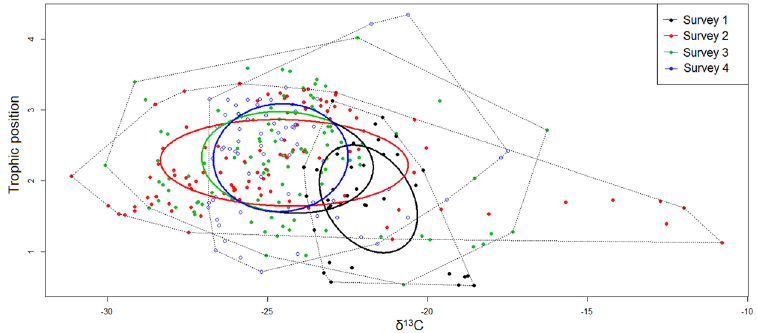
Figure 2. Trophic diversity for invertebrates over the course of a hydroperiod for an ephemeral pond depicted by total convex hull areas (dotted lines) and standard Bayesian ellipse areas (solid